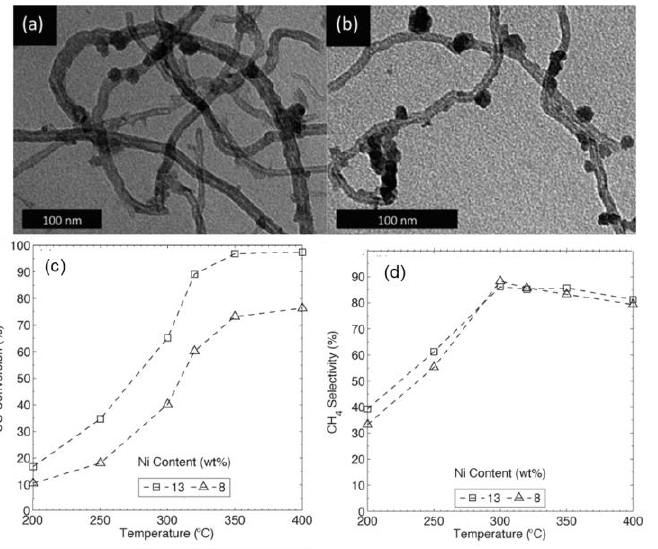
Figure 5. Ni nanoparticles supported on carbon nanotubes (CNTs) as catalyst for the methanation reaction ( a ) and ( b ). CO conversion and CH 4 selectivity, ( c ) and ( d ), for selected Ni-CNT catalysts. Reproduced from [86] with permission of The Royal Society of Chemistry 2020.